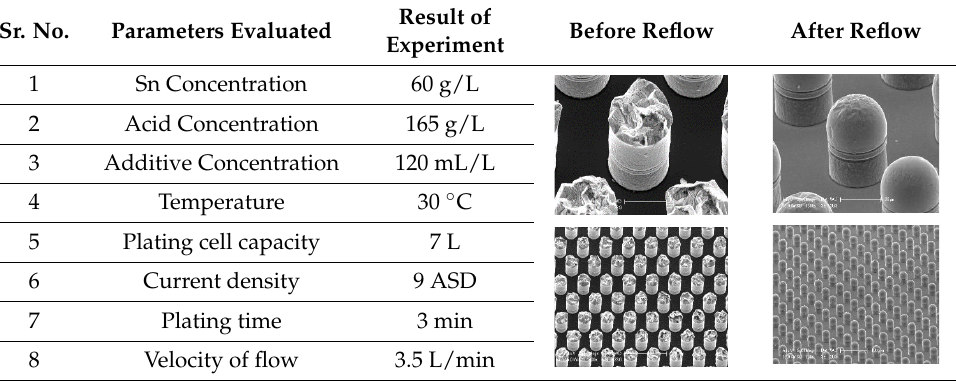
Figure 6. Cross-section images of Sn bump with one reflow. Table 6. Process conditions and images of microbump.